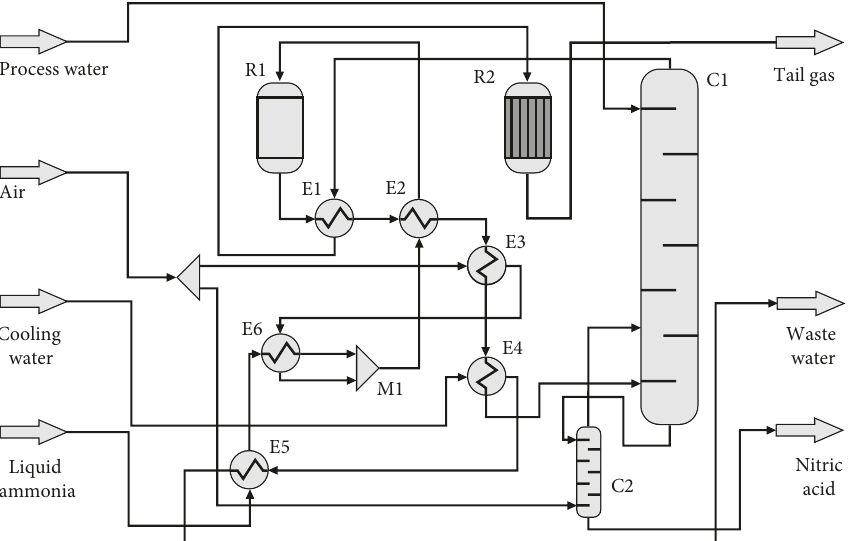
Figure 2: Scheme of the pilot plant. C1, absorption column; C2, bleaching column; E1–E6, heat exchangers; M1, air-ammonia mixer; R1, ammonia oxidation reactor; R2, selective catalytic reduction reactor.